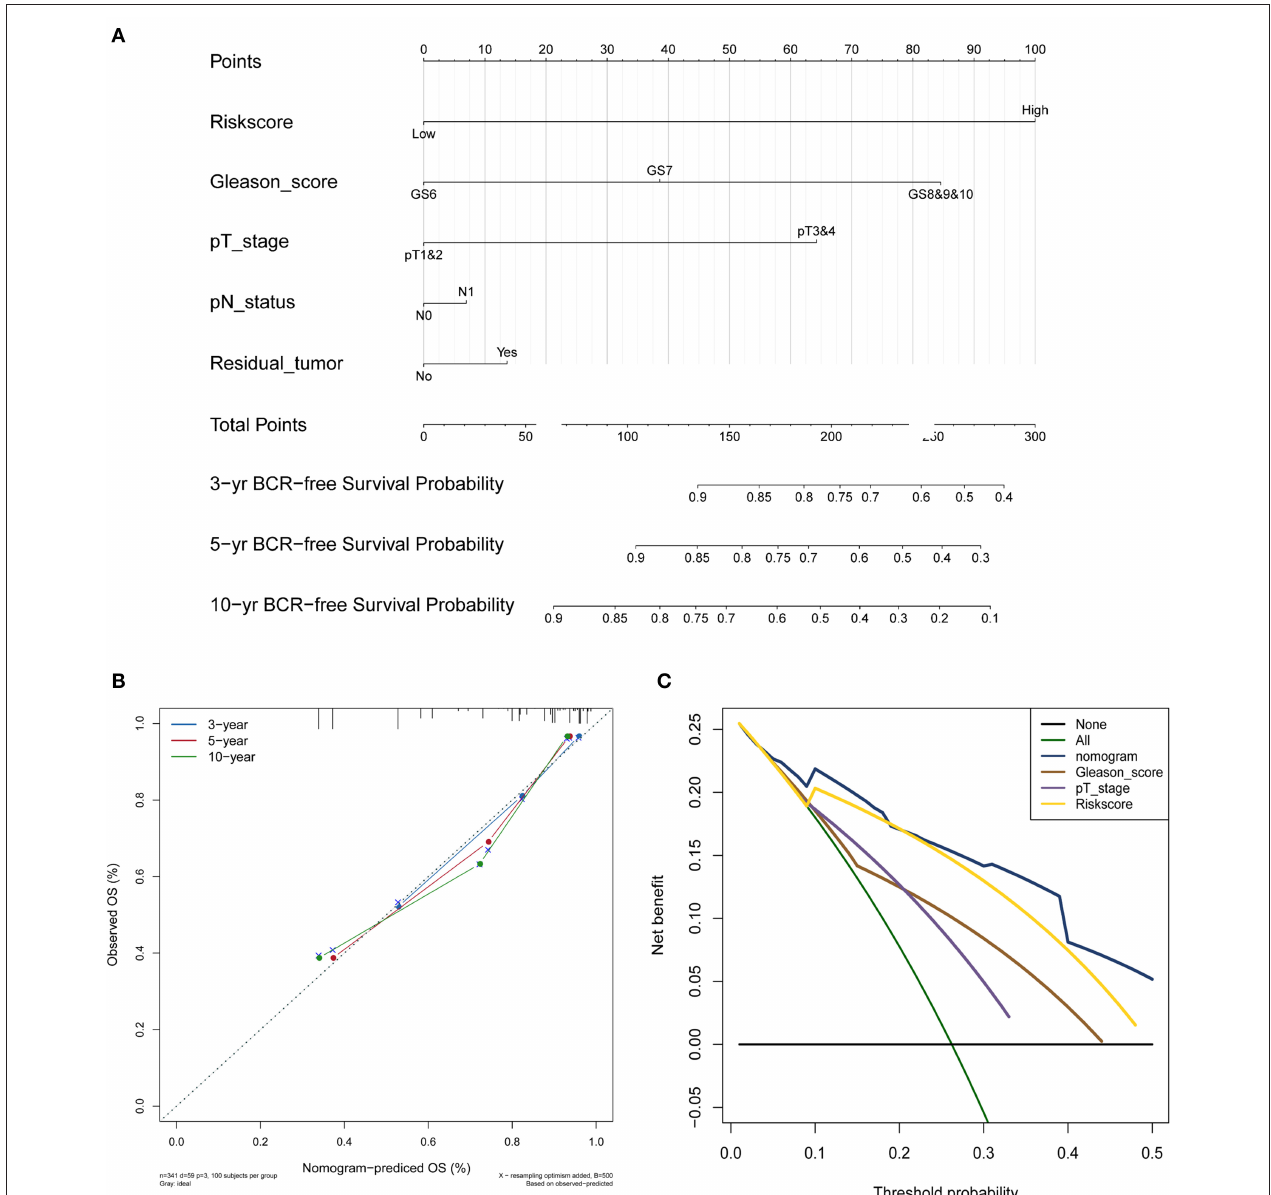
FIGURE 5 | PCa survival nomogram, calibration curve, and Net benefit curves. (A) Survival nomogram. each variable axis represents the value of individual patient, and a line is plotted upward to decide the number of points received for each variable value. The Total Points axis represents the total of these numbers, and a line is plotted downward to the survival axes to deicide the probability of 3-, 5-, and 10-year BCR-free survival. (B) The calibration curve for predicting PCa patient survival at 3, 5, and 10 years in the entire cohort. (C) Net benefit curves for the nomogram, signature, and other clinical features, along with their confidence intervals. P -values indicate the area under curve (AUC) at 5 years for nomogram verse the AUC at 5 years for other